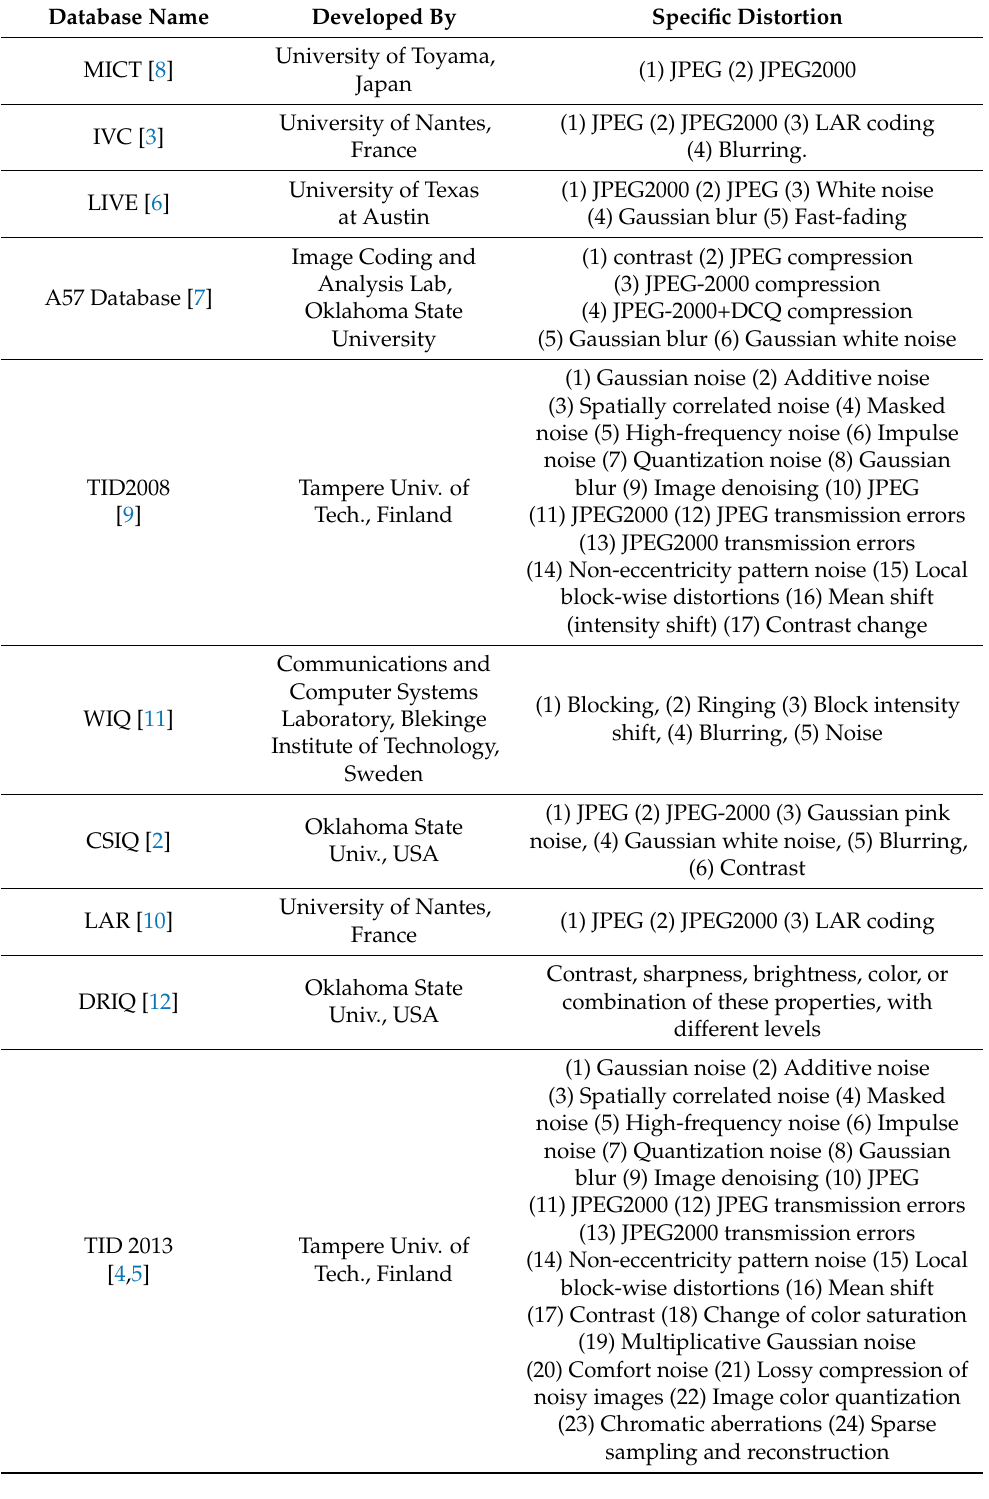
Table 2. Details of distortions used in popular image quality